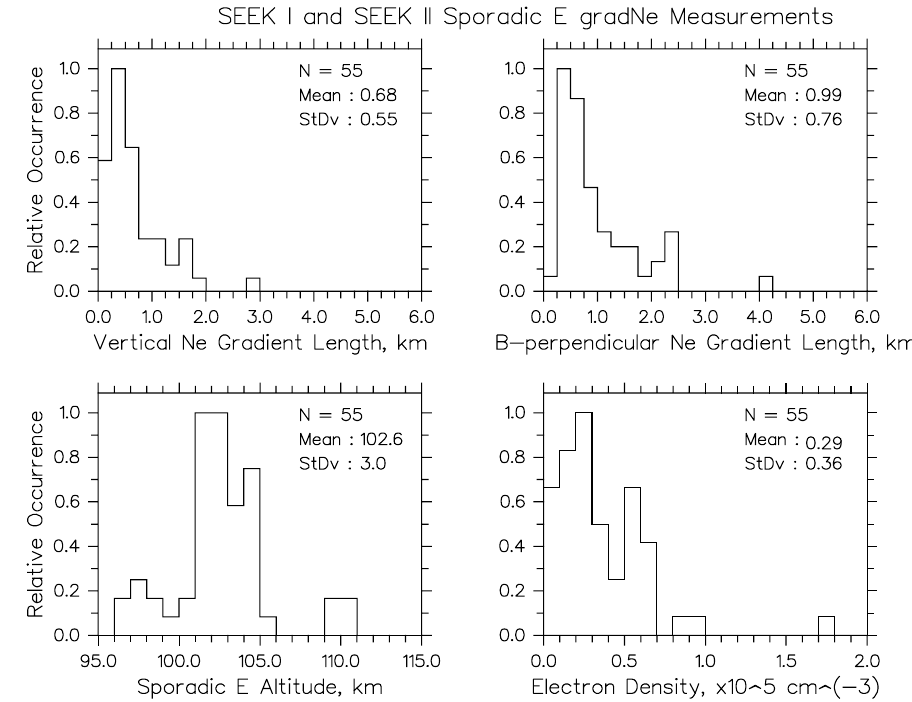
Fig. 4. SEEK I and II plasma density gradient statistics during sporadic E-layer instabilities (upper panels). The lower panels show the distributions of the sporadic E-layer altitude and electron density. Here of interest is the prevailing plasma density gradients perpendicular to the magnetic field (top-right histogram) because, according to the theory, they can act to destabilize or stabilize the plasma to Farley-Buneman